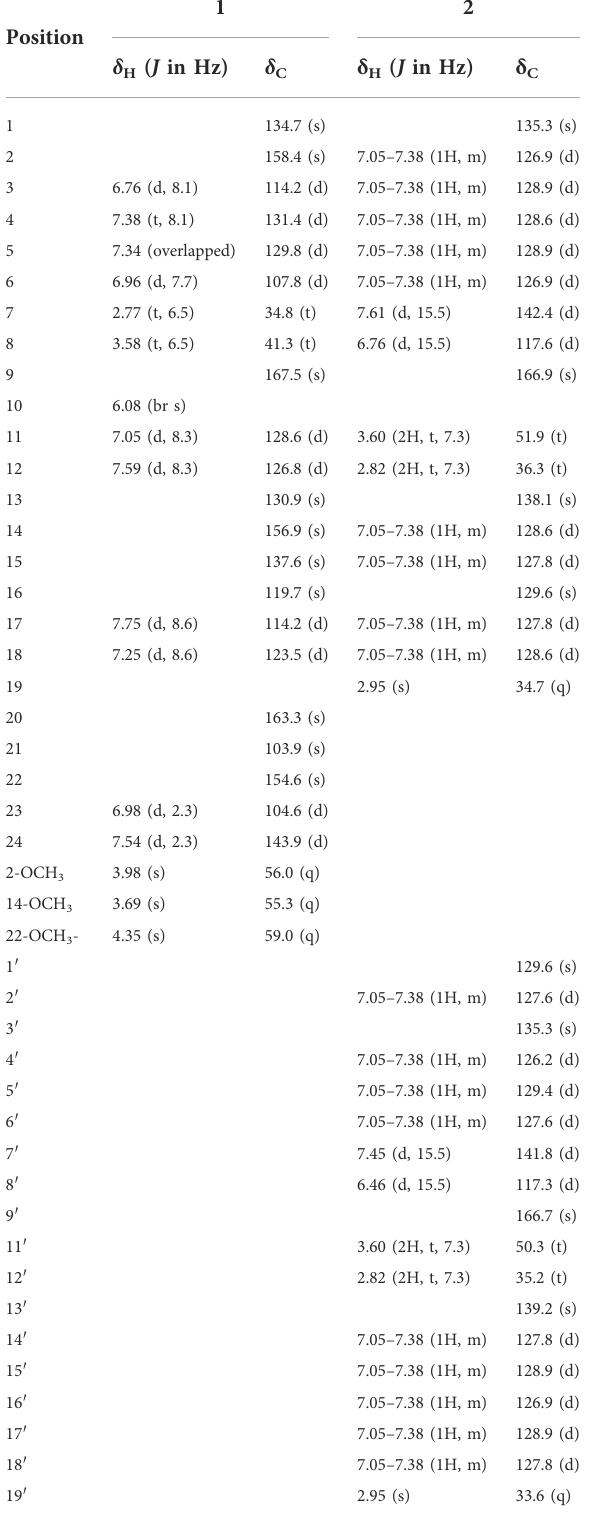
TABLE 1 1 H (400 MHz) and 13 C (100 MHz) NMR Data of. 1 and 2 in